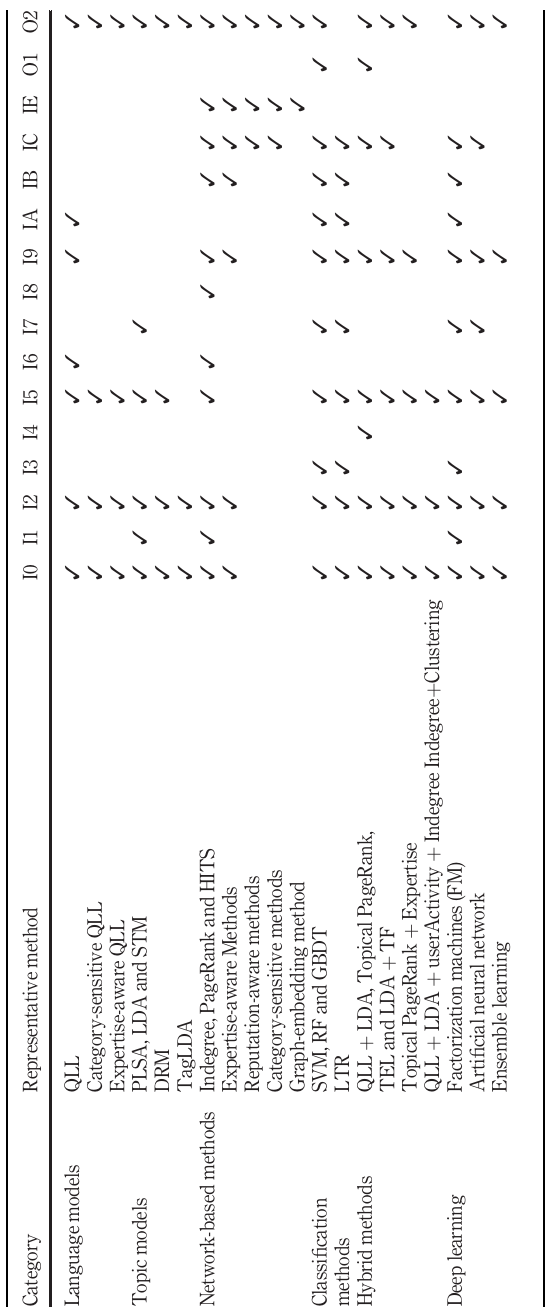
Table IV. Comparison of inputs and outputs of representative expert recommendation